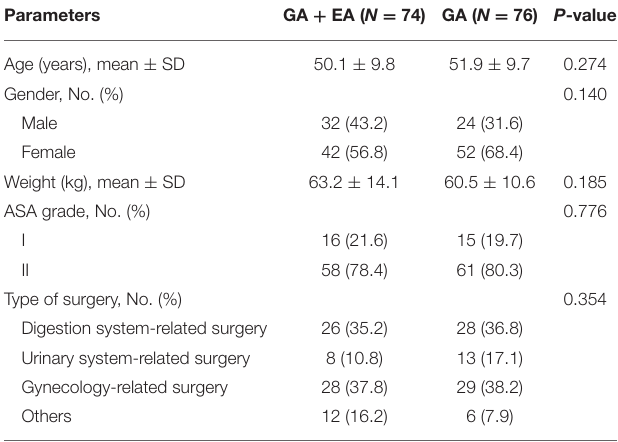
TABLE 1 | Characteristics of